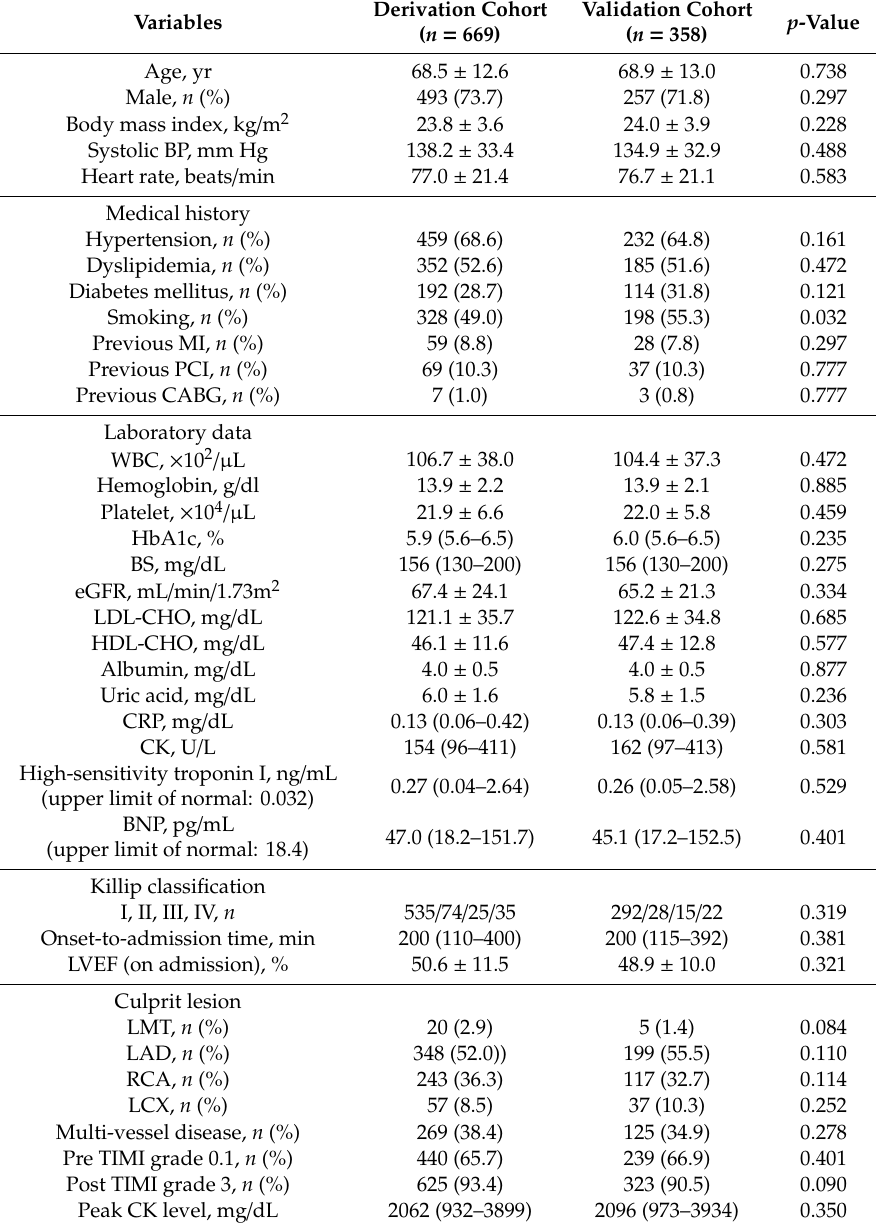
Table 1. Baseline characteristics of patients subdivided into derivation and validation